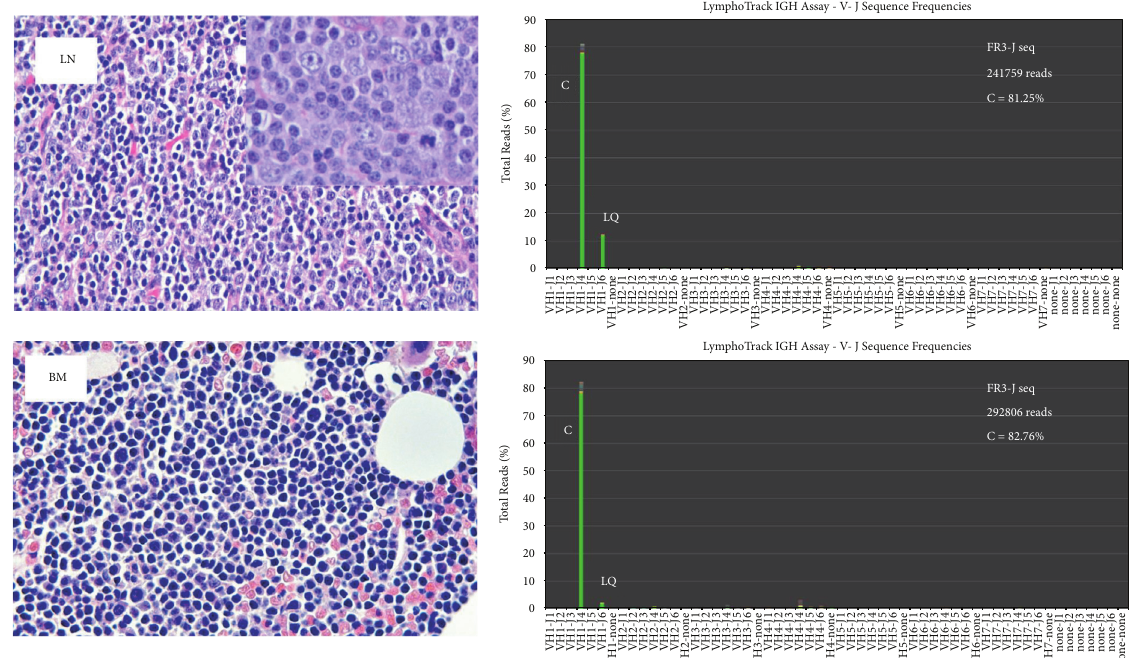
Figure 1: Tumor histology and V-J frequency graphs. On the left are H&E sections from the DLBCL in the lymph node and CLL/SLL in the bone marrow. Inset: high-power view of the DLBCL in the lymph node. On the right are the V -J frequency graphs from FR3-J primers showing the clonal and LQ reads. The Y -axis is the % of total reads, and X -axis is the specific V -J rearrangement. Clonal reads are present in both the lymph node and bone marrow. C: clonal, V1-2 ∗ 02/ D 5-12 ∗ 01/J4 ∗ 02, LQ: LymphoQuant control, and V1-69 ∗ 01/ D 6-13 ∗ 01/J6 ∗ 03.